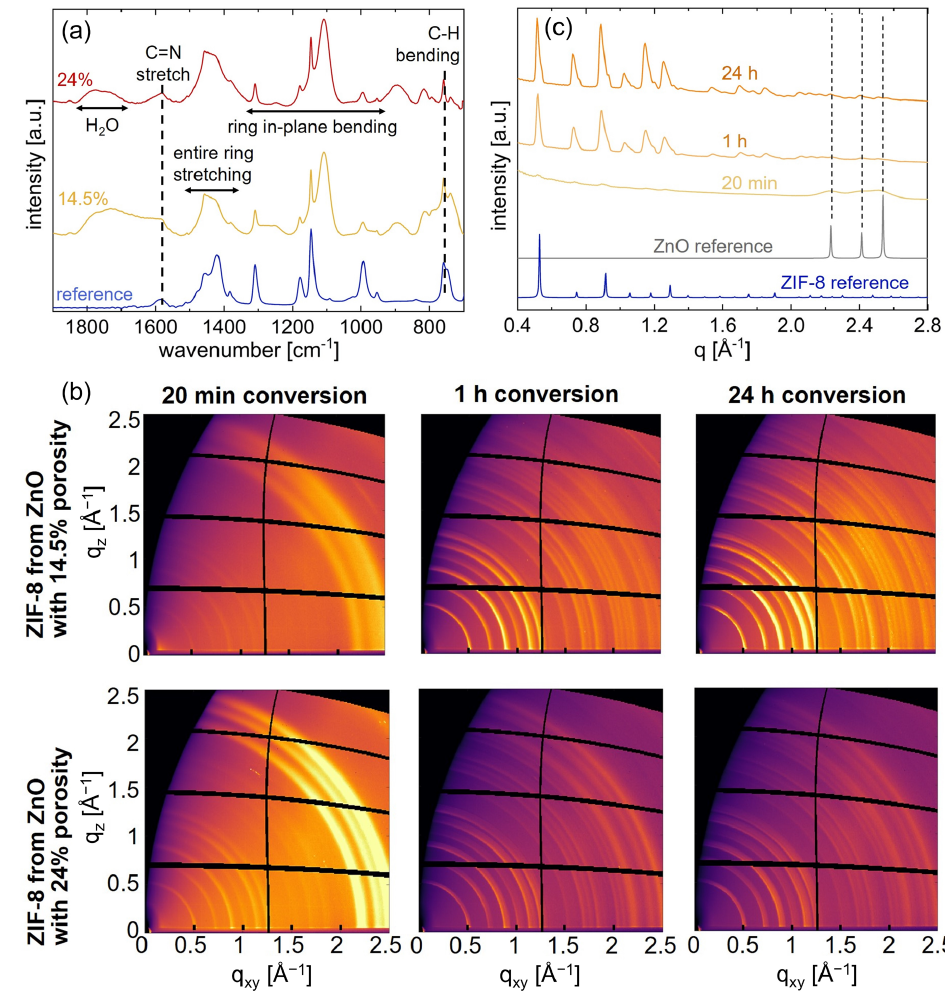
Figure 3. ( a ) Fourier transform infrared spectroscopy of ZIF-8 converted for 24 h from ZnO thin films with open porosities of 14.5% and 24% compared to data of a ZIF-8 powder reference. ( b ) Grazing incidence X-ray diffraction (GIXD) measurements of ZIF-8 grown from porous ZnO, with conversion times between 20 min to 24 h. ( c ) Line scans of grazing incidence X-ray diffraction (GIXD) measurements of ZIF-8 grown for 20 min to 24 h from ZnO with an open porosity of 14.5%. Powder reference patterns of ZnO and ZIF-8 are shown for comparison [43,45].